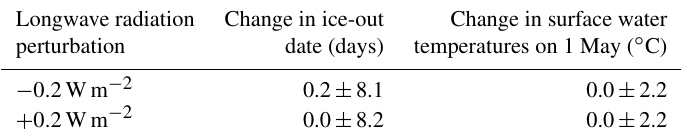
Table A6. Results from the lake energy balance model for longwave radiation perturbations showing the change in ice-out dates and